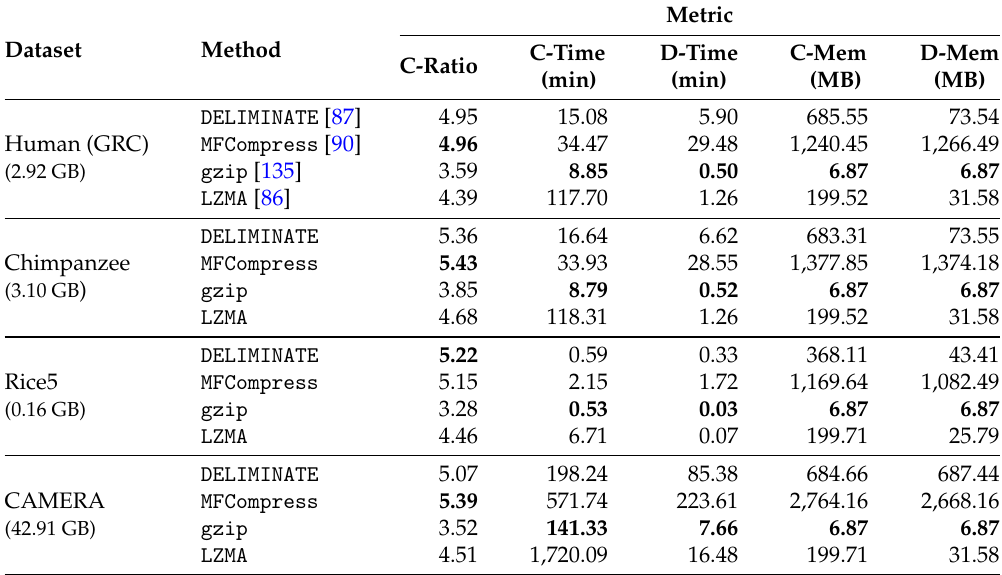
Table 3. Reference-free compression results of genomic sequence data for FASTA/Multi-FASTA file format.